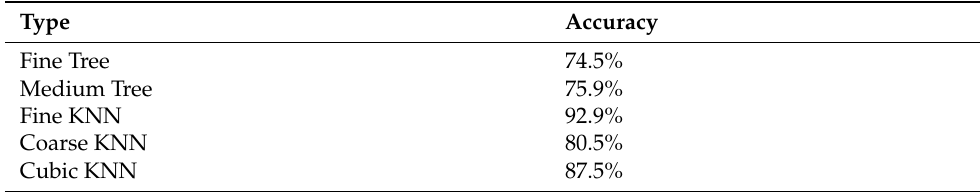
Table 2. Results of a vocabulary bank of 500 words.